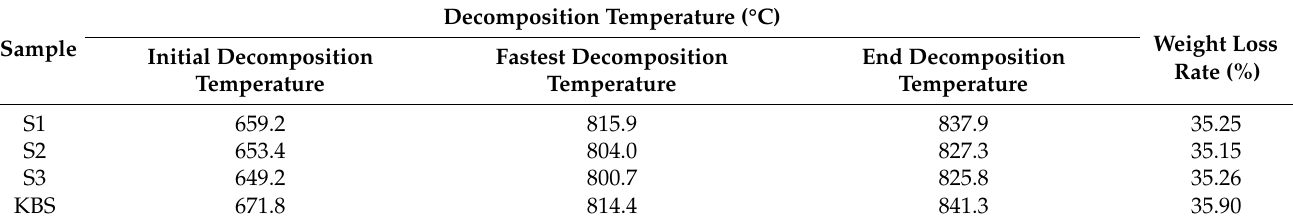
Table 4. Thermal analysis results of Portland road cement